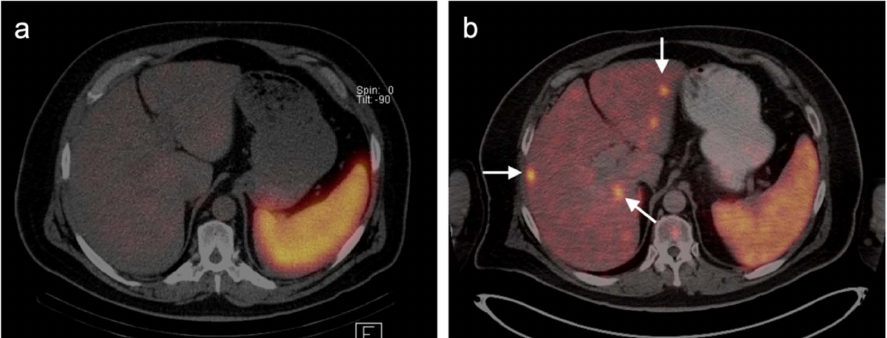
Figure 36. Metastatic carcinoid in the liver: comparison of [ 111 In]In-pentetreotide (OctreoScan ® ) SPECT-CT and [ 64 Cu]Cu-DOTA-TATE (Detectnet ® ) PET-CT. ( a ) An axial OctreoScan ® SPECT-CT image of the upper abdomen shows no obvious liver metastases. ( b ) An axial Detectnet ® PET-CT scan performed a short time later shows multiple focal PET-positive lesions within the liver white arrows) and a single vertebral lesion that were not seen on Octreoscan ® SPECT-CT. This illustrates the difference in sensitivity between OctreoScan ® SPECT-CT and SSTR